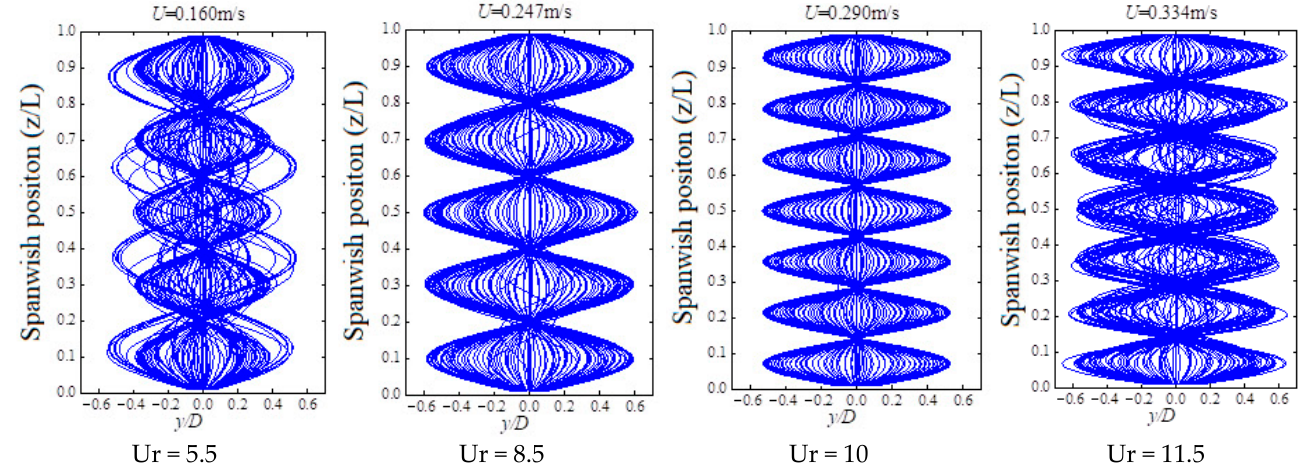
Figure 12. Modal Response of Riser under Different Flow Velocity at 0°.